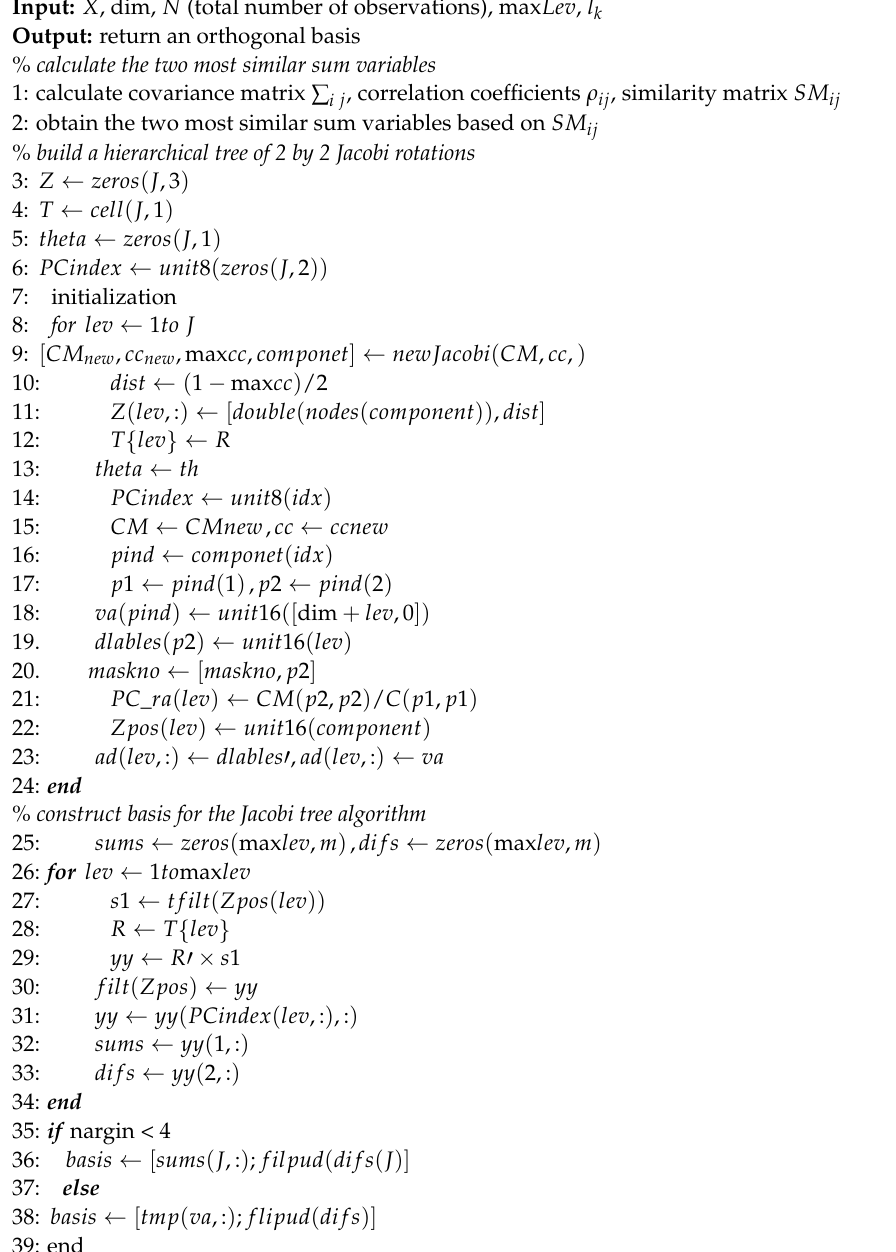
Algorithm 1 The spatial–temporal correlation basis algorithm with highly efficient